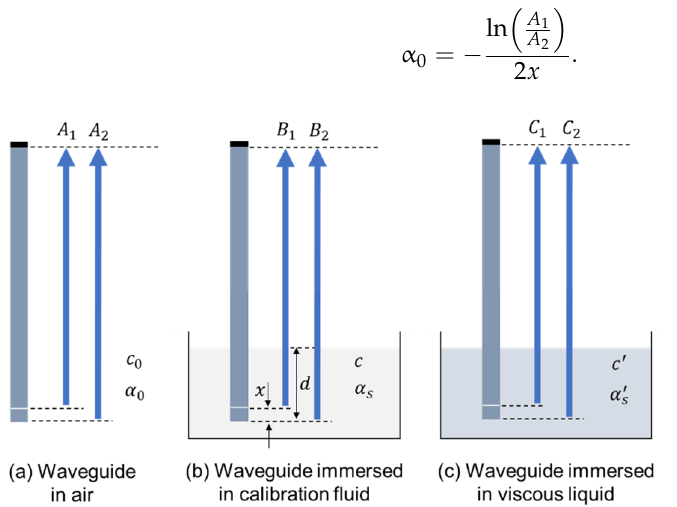
Figure 2. Schematic diagram showing the signal difference in a waveguide ( a ) in air; ( b ) immersed in calibration fluid and ( c ) immersed in a viscous liquid. calibration fluid and ( c ) immersed in a viscous